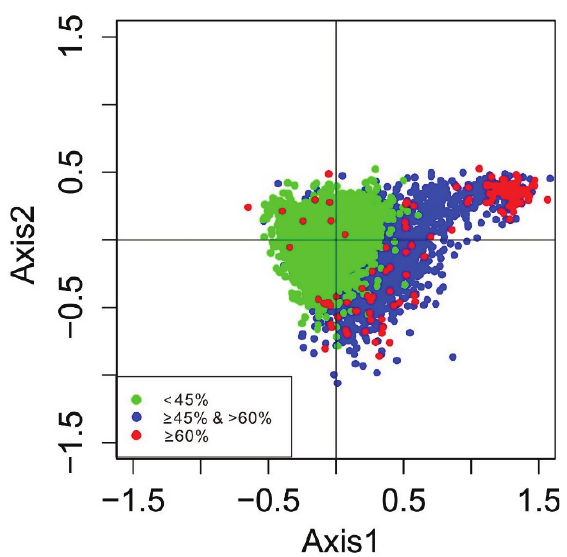
Figure 5. Correspondence analysis of codon usage patterns: the distribution of genes is shown along the first and second axes. Note: red, green and blue dots indicate genes with G + C content greater than or equal to 60%, greater than or equal to 45%, but less than 60%, and less than 45%, respectively.